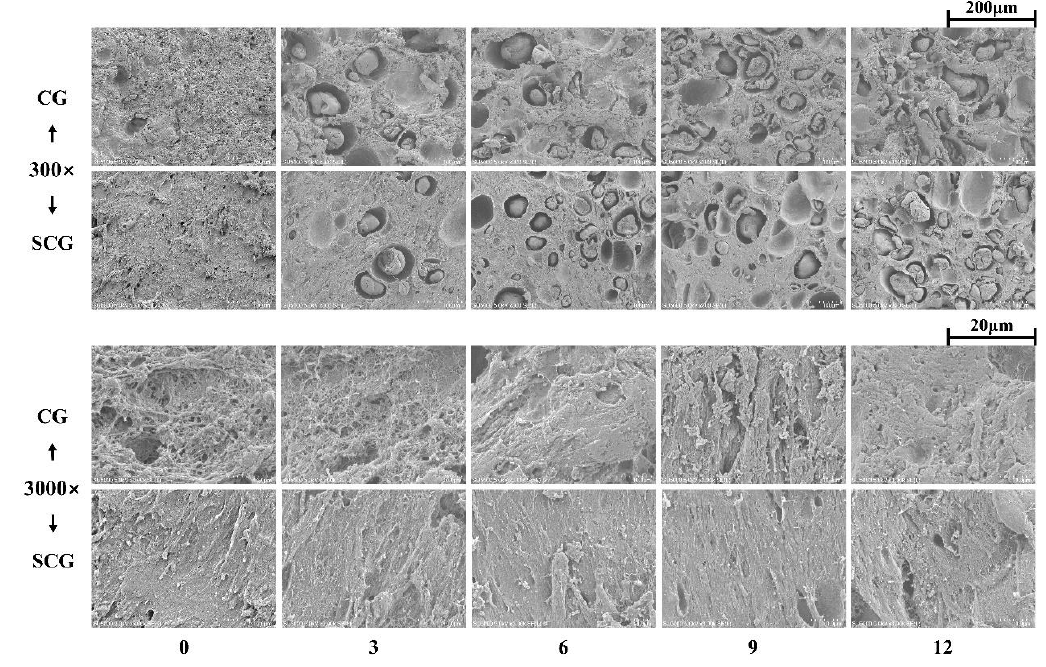
Figure 4. Microstructure micrographs (magnification ×300, ×3000) of starch – surimi matrix subjected with different heating processes: 0, 3, 6, 9, and 12 represented 0%, 3%, 6%, 9%, and 12% starch content, respectively. Caption: See Figure